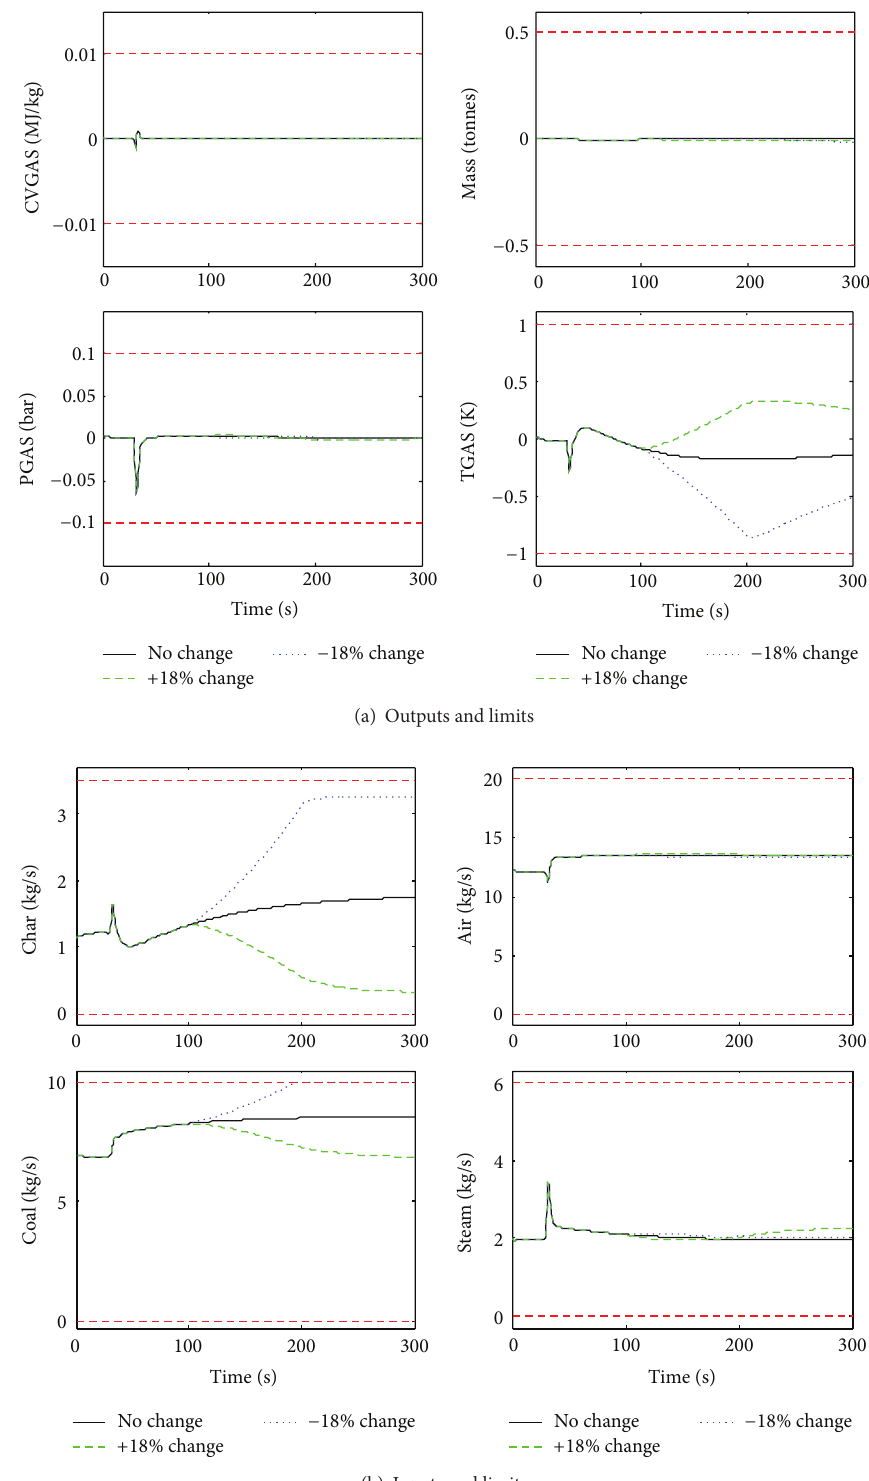
Figure 10: Response to step disturbance at 50%